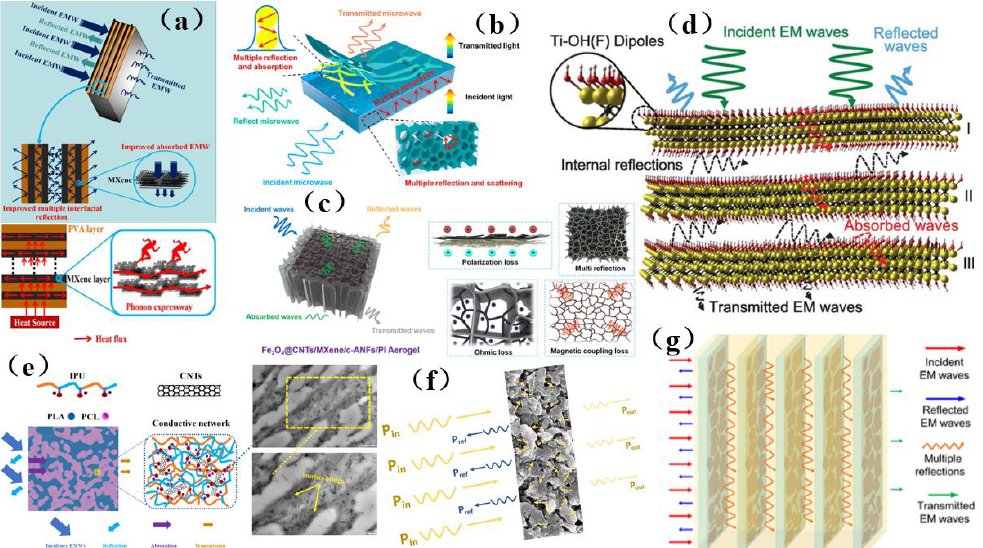
Figure 27. ( a ) Electromagnetic microwave dissipation mechanism and heat conduction